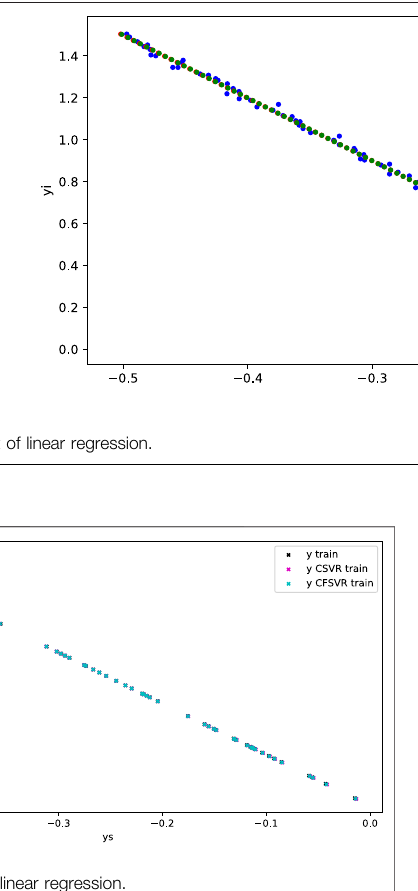
FIGURE 2 | Test result of linear regression.